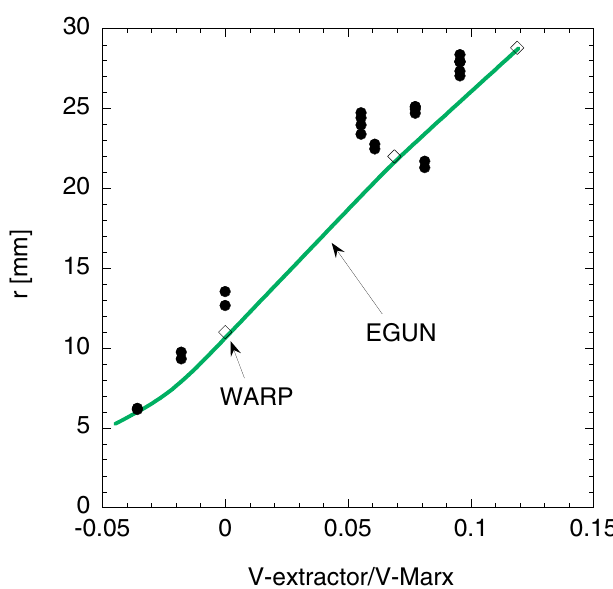
FIG. 11. (Color) Comparison with EGUN model of perveance (in units of 10 (cid:2) 9 A = V 3 = 2 ) representing current exiting the diode as measured by a Faraday cup. The circles and squares represent data taken on two separate days, showing the level of day-to-day reproducibility in the measurement.